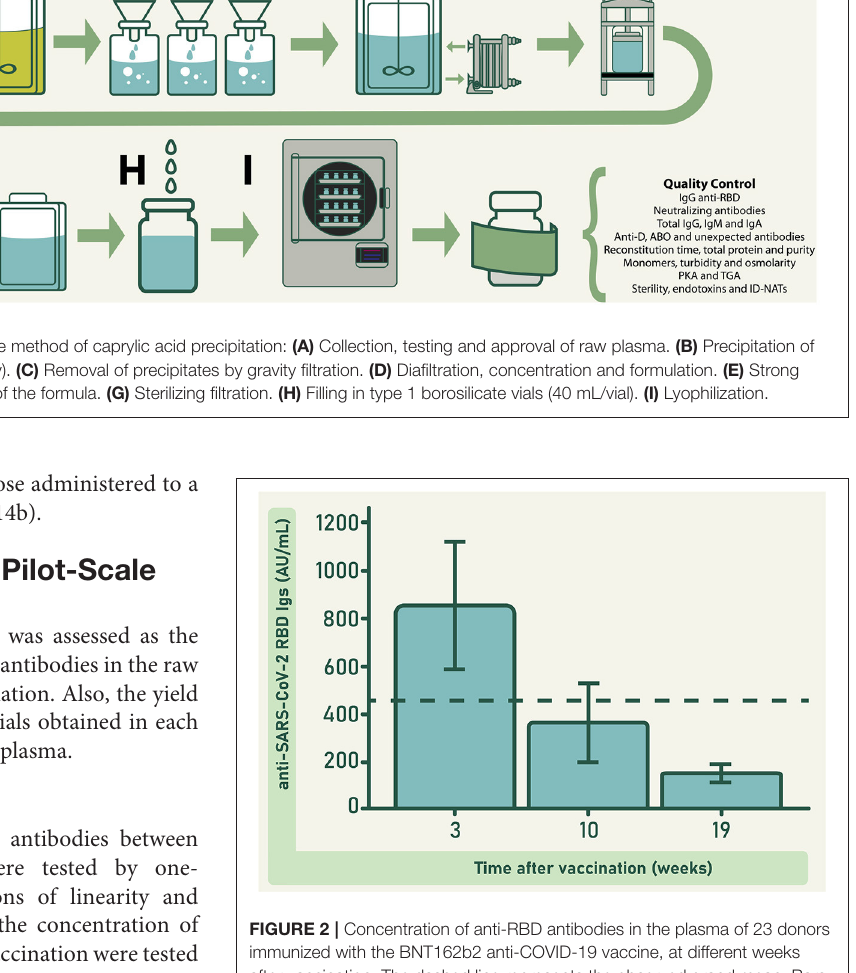
FIGURE 2 | Concentration of anti-RBD antibodies in the plasma of 23 donors immunized with the BNT162b2 anti-COVID-19 vaccine, at different weeks after vaccination. The dashed line represents the observed grand mean. Bars represent the estimated marginal means ± 95 CI. Differences at different times were significant ( F = 35.560; d f = 2; 40; p ≤